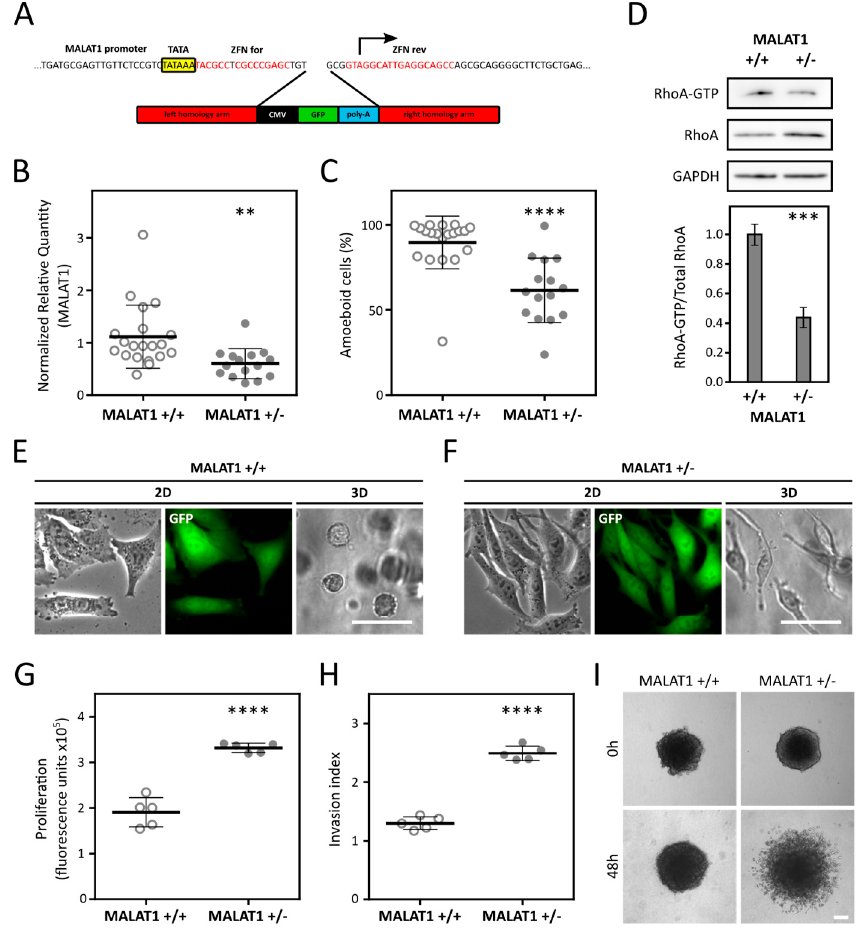
Figure 3. MALAT1 level and morphology of clones derived from the A375m2 cell line. ( A ) Zinc-finger nuclease (ZFN) system for MALAT1 depletion. The zinc-finger nucleases cleave between TATA box (yellow) and the site of transcription start (arrow). The binding motifs for ZFNs are depicted in red. The integration of the cassette into MALAT1 loci is mediated by homologous recombination using left and right homology arm. ( B ) RT-qPCR analysis of the MALAT1 gene expression in A375m2-derived clones. Data represent the mean ± SD. ( C ) Quantification of clones’ morphology in 3D collagen. Data represent the mean ± SD. N MALAT1 +/+ ) = 20 clones; N(MALAT1 +/ − ) = 15 clones. ( D ) Pull-down of active RhoA from 3D samples of pooled clones. Representative immunoblots are in upper part, lower part represents the densitometry quantification. Data represent the mean ± SEM. ( E ) Representative images of a control clone in 2D environment (Petri dish) and in 3D collagen matrix. ( F ) Representative images of a heterozygous clone in 2D environment and in 3D collagen matrix. ( G ) Proliferation of selected clones in 3D collagen. Data represent mean fluorescence of AlamarBlue ± SD. ( H ) Quantification of cell invasion from spheroids. Data represent the mean ± SD. ( I ) Representative images of invasion of control and heterozygous MALAT1 clones from spheroids. p -values: **** p < 0.0001, *** p < 0.001, ** p < 0.01. Scale bar 50 µ m in parts ( E , F ) and 150 µ m in part ( I ). Part ( A ) was taken and modified from [34].